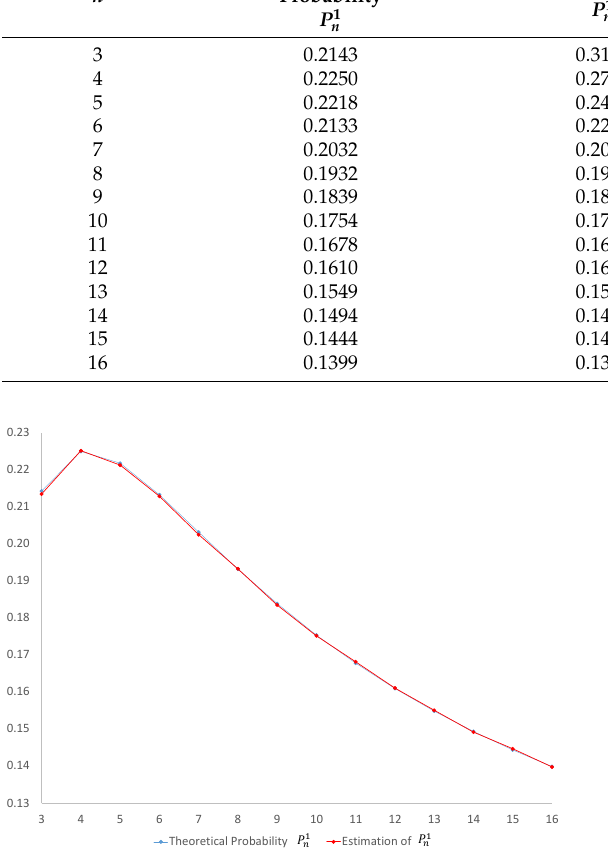
Figure 7. For n = 3, . . . ,16: Graph of the Theoretical probabilities P 1 n of falling into the same Hamming Weight class after a random swap (in blue) and comparison with its estimate (in red) using M = 1,000,000 successive permutations fixed initially.